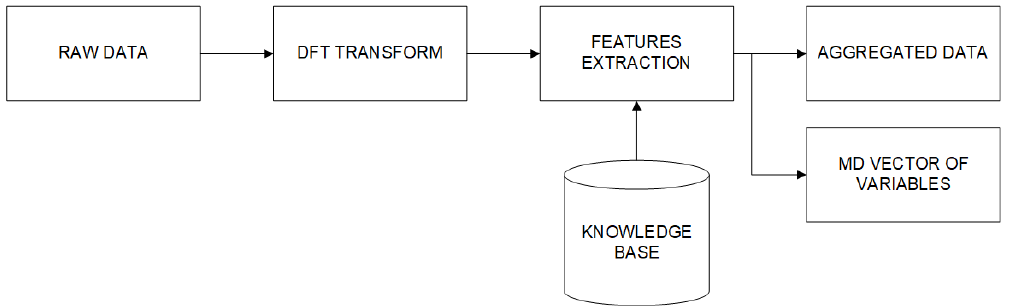
Figure 1. The link between the analysis of frequencies in the spectrum of the signal and the localization of wear in the machine.